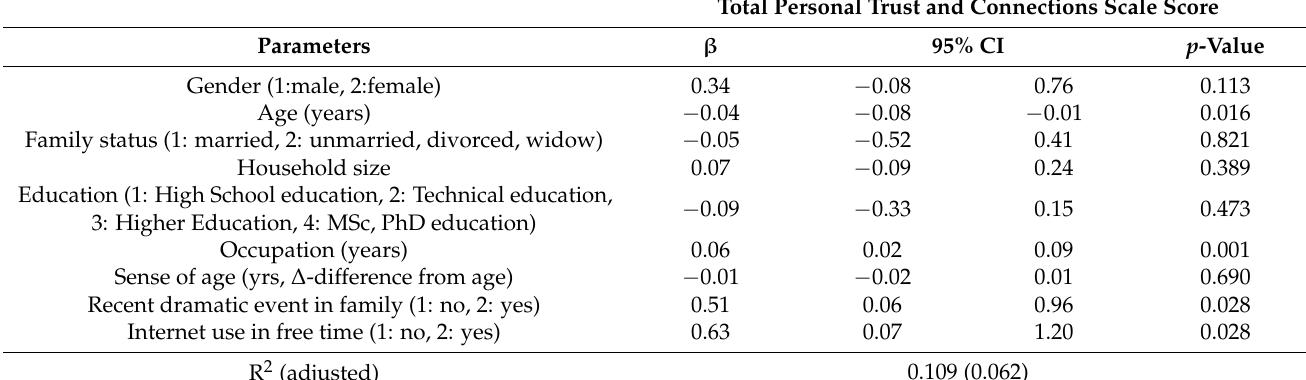
Table 6. Multiple linear regression analysis of ‘Scale of Personal Trust and Connections’ scores and the characteristics of 218 study